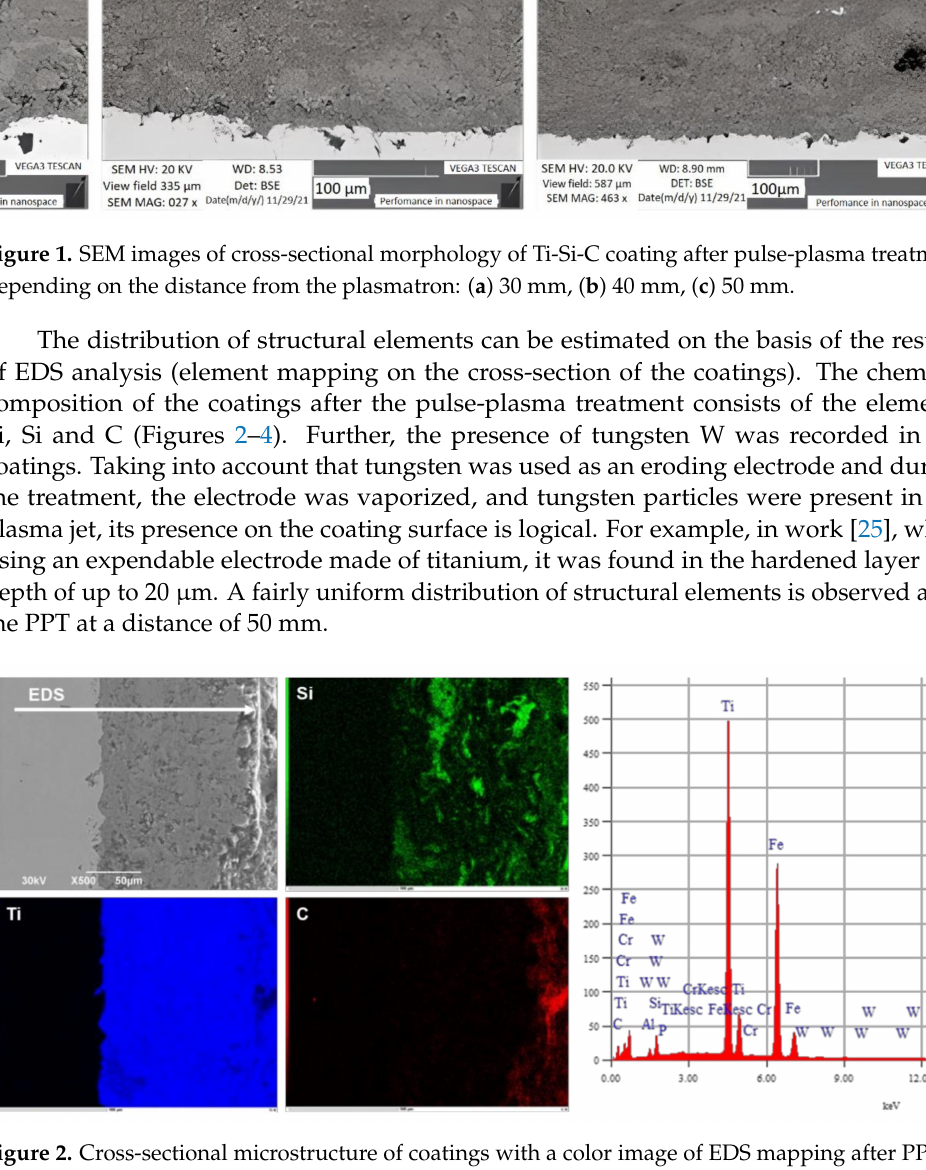
Figure 2. Cross-sectional microstructure of coatings with a color image of EDS mapping after PPT at a distance of 30